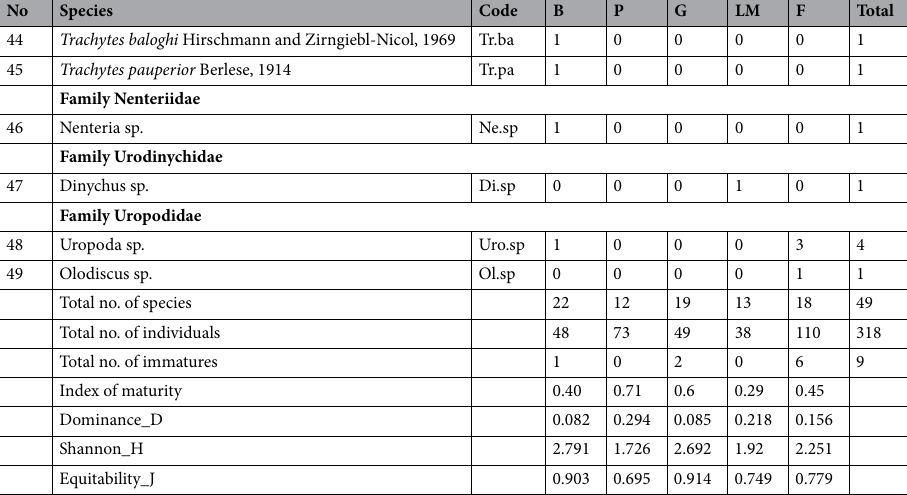
Table 4. The numerical abundance of Mesostigmata mites from UGA areas from Bucharest, 2017.